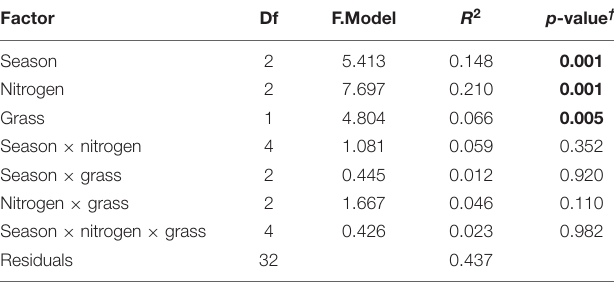
TABLE 2 | Results of PERMANOVA examining the effects of season, N fertilization rate, and grass species on diazotrophic community composition, based on weighted-UniFrac distances of nifH